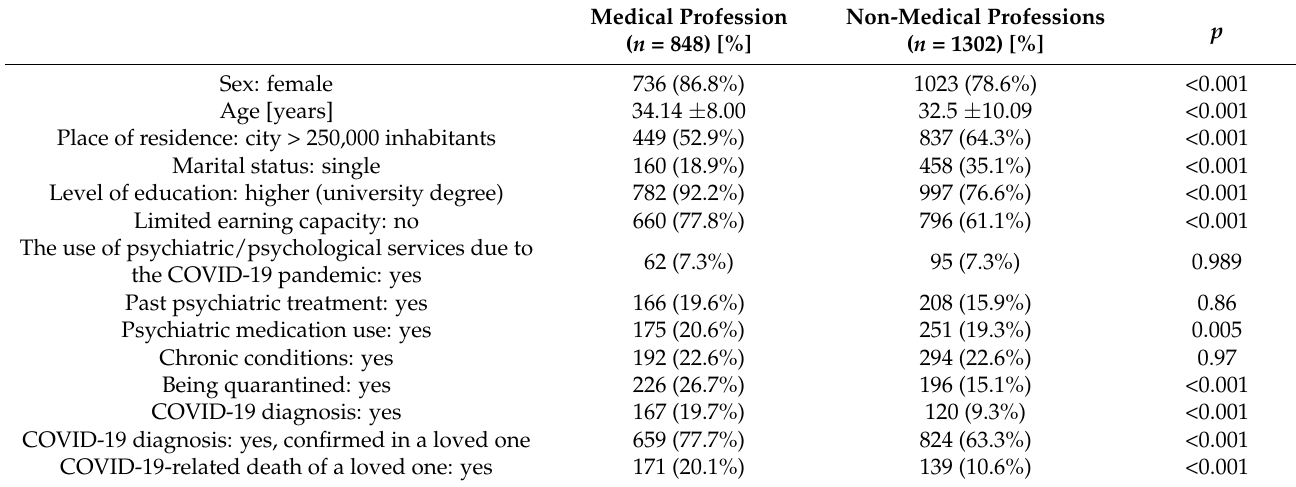
Table 1. Distribution of the study group according to medical/non-medical profession.